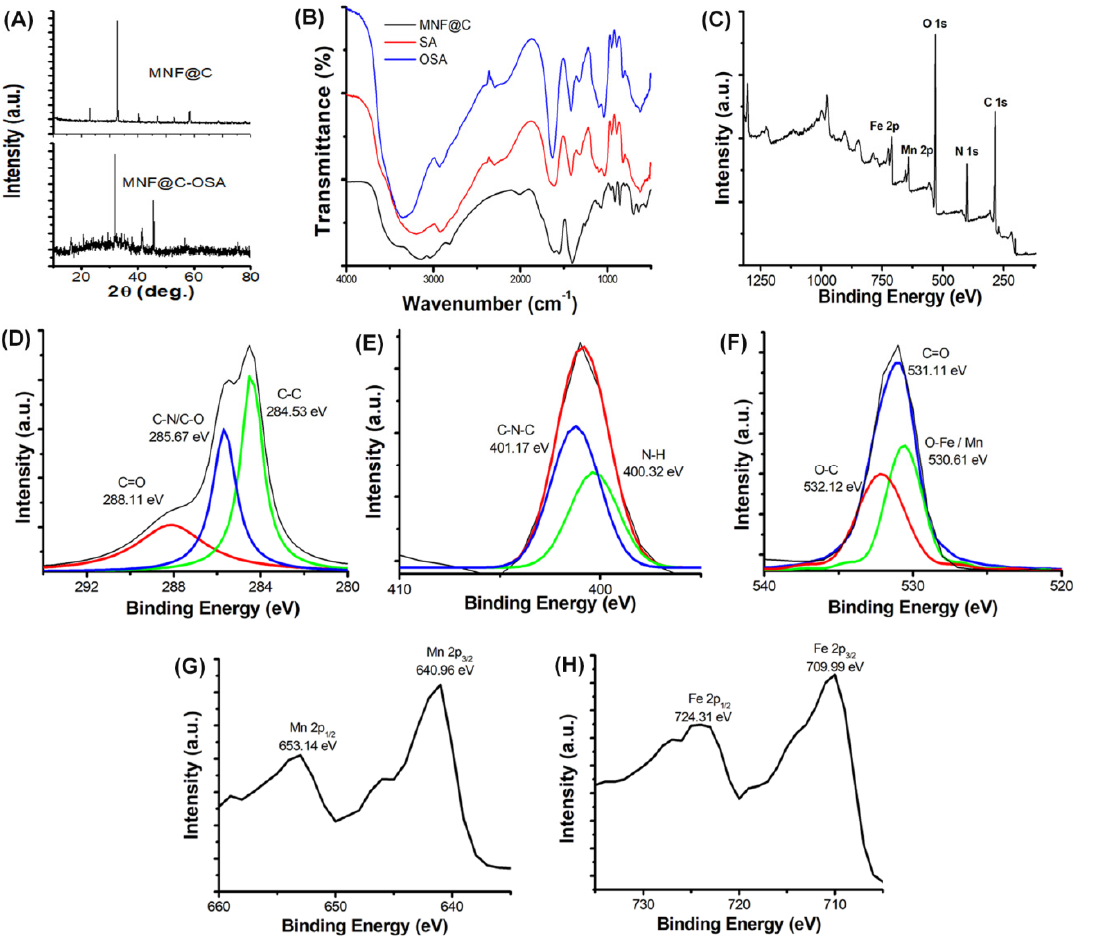
Figure 1. ( A ) XRD images of MNF@C and MNF@C-OSA dots. ( B ) FTIR spectra of MNF@Cs, sodium alginate (SA), and oxidized sodium alginate. ( C ) XPS image of MNF@Cs to confirm the structure and chemical composition. Fitted narrow-range XPS spectra of ( D ) C 1s, ( E ) N 1s, ( F ) O 1s, ( G ) Mn 2p, and ( H ) Fe 2p of